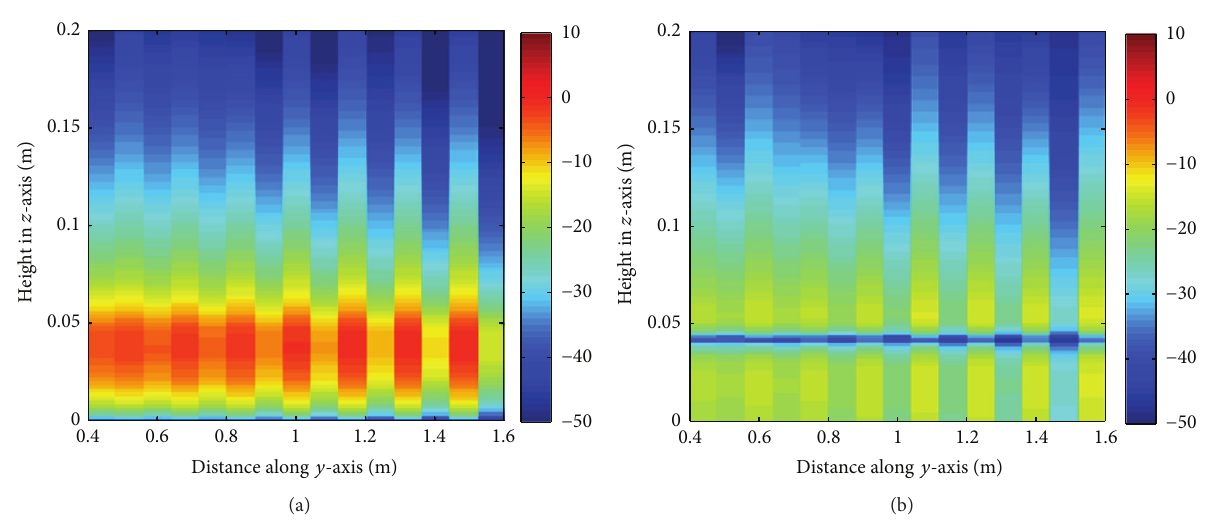
Figure 4: Simulated near field distribution in the 𝑦 - 𝑧 plane at 390 MHz: (a) 𝐸 𝑦 and (b) 𝐸 𝑧